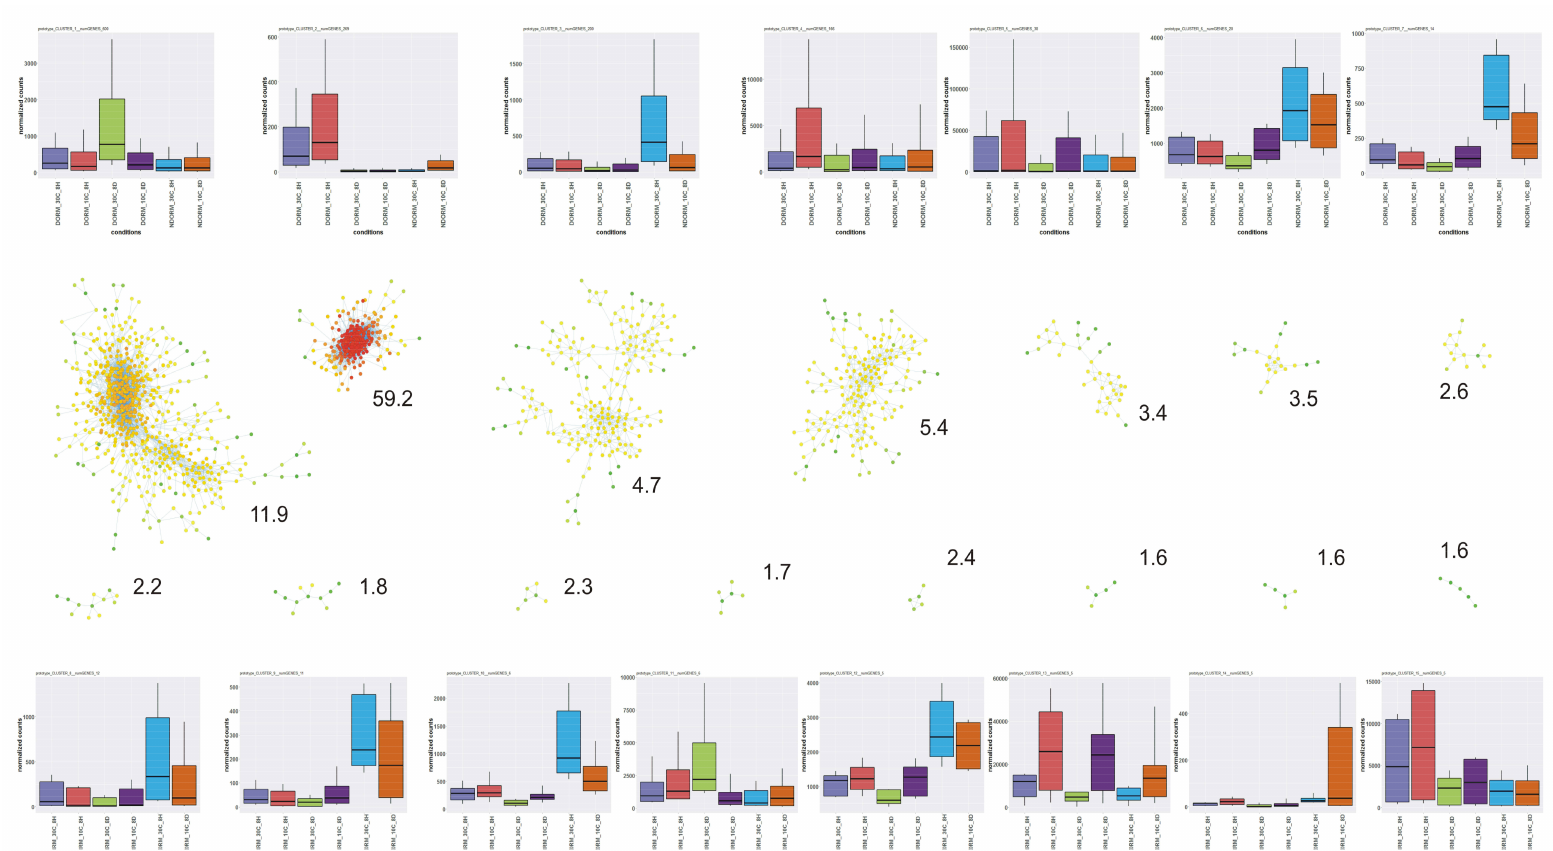
Figure 9. Co-expression network analysis: the clusters with at least five nodes (i.e., genes with correlated expression) are shown. Next to each cluster, its average node degree (i.e., average number of connections per node) is reported. Every node is colored according to its neighborhood connectivity (nc; that is, the average node degree of all the neighbors of that node), with green indicating a nc = 1 and increasing redness corresponding to an increasing nc value, with a maximum of 118.64. Next to every cluster, a box plot shows, for each tested condition, the median, the interquartile range, and the 15th and 85th percentiles (which are represented by the lower and upper whisker, respectively) of average expression level of the genes in the